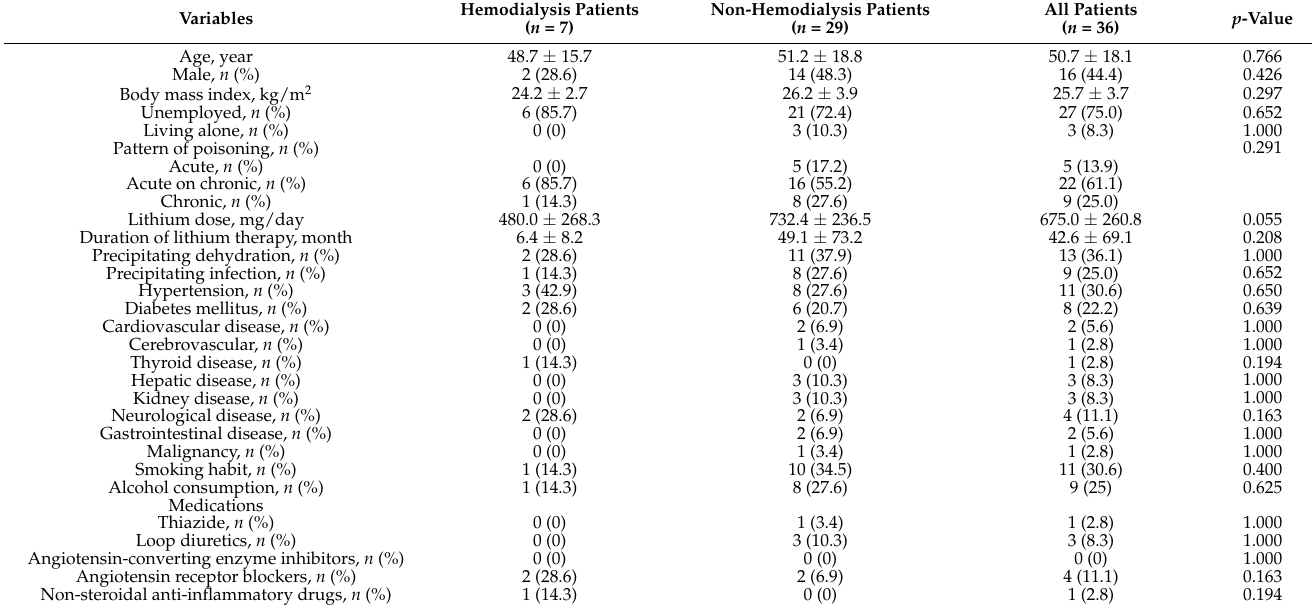
Table 2. Baseline characteristics of patients with lithium poisoning, stratified according to whether they were treated with hemodialysis or not ( n =